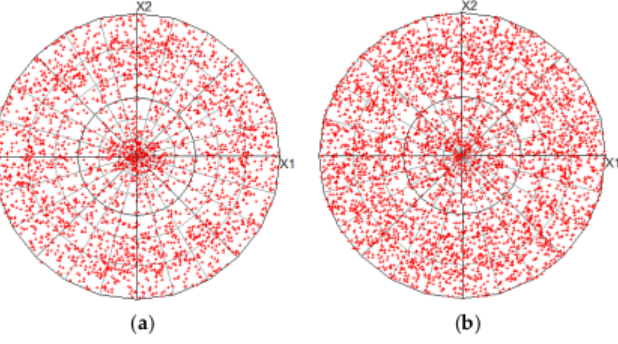
Figure 6. Pole figures for directions < 111 > (projection from the OX 3 -axis): ( a ) for the initial moment ( H 33 = 1.1 ), ( b ) after tension at H 33 =